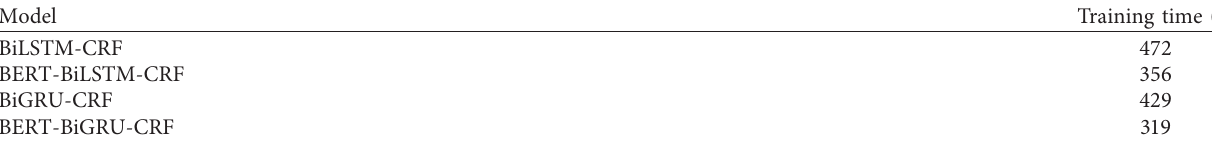
Table 5: Time of one round of model